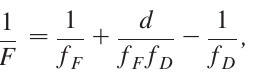
FIG. 10. Sketch view of the doublets, F is the equivalent focal length, d is the distance between the two lenses, L distances between the focal point and the nearest